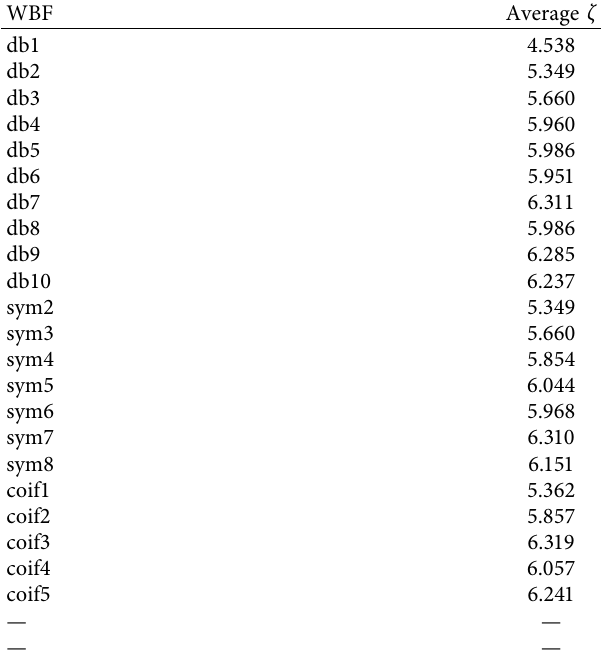
Table 2: The average value of the total energy-to-Shannon entropy ratio ζ .